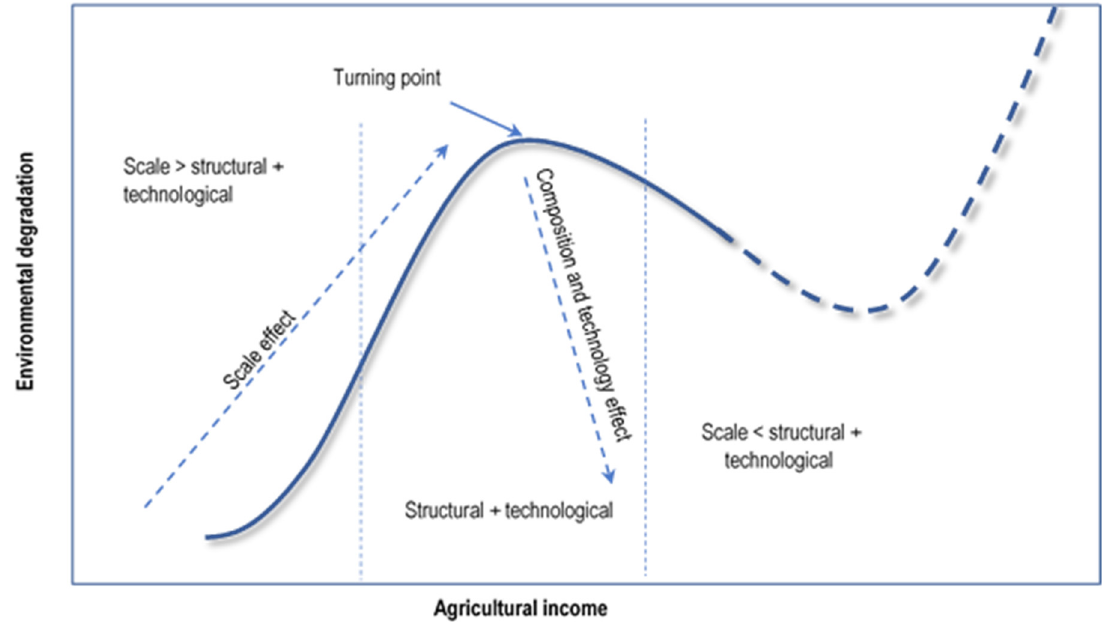
Figure 4. Kuznet curves model.